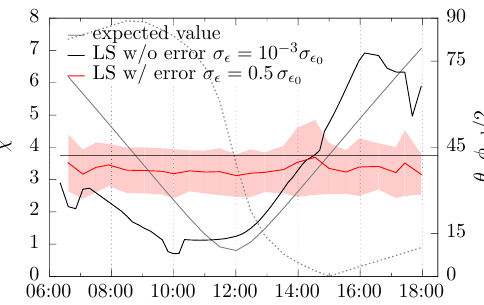
Fig. 7. Residual for the retrieval shown in Fig.